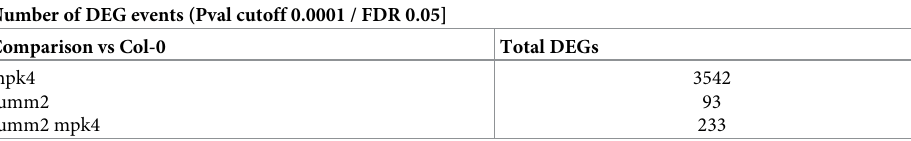
Table 1. Total number of DEG in mpk4, summ2 and summ2mpk4 as compared to Col-0 in the presence or not of flg22. Number of DEG events (Pval cutoff 0.0001 / FDR